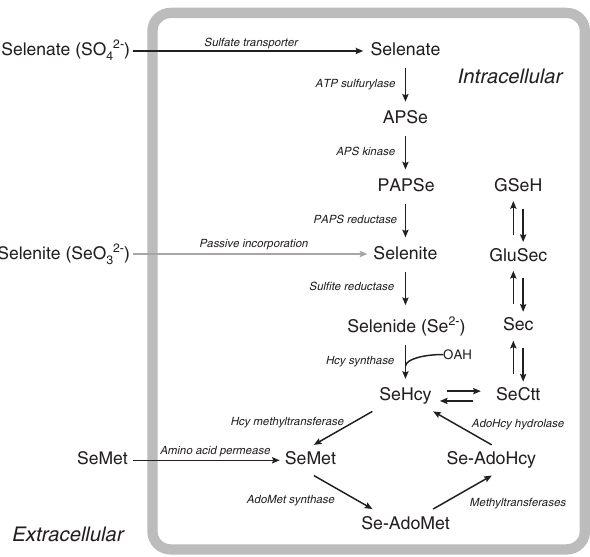
Figure 1 Selenium (Se) metabolism in Saccharomyces cerevisiae . Extracellular selenate and selenomethionine (SeMet) are